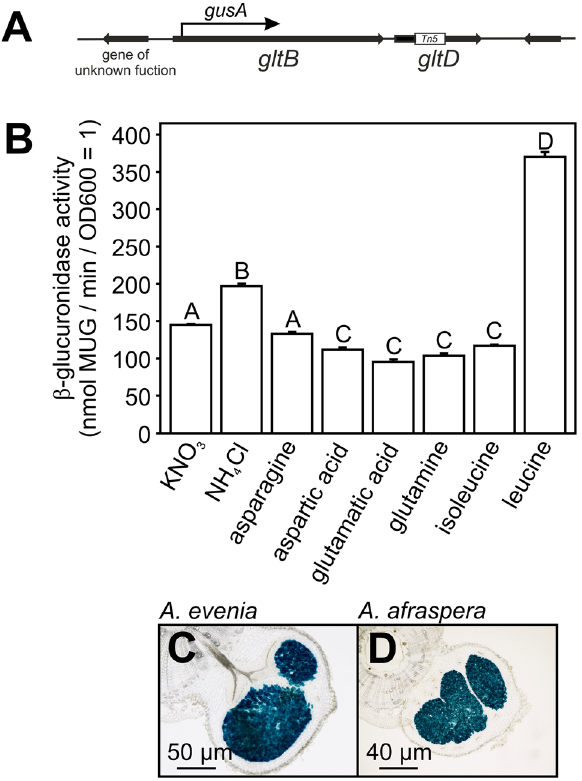
Figure 3. Activity of the Bradyrhizobium ORS285 GOGAT promoter under free-living and symbiotic conditions. ( A ) Schematic representation of the genomic region containing the gltB - gltD operon in Bradyrhizobium ORS285. The insertion of the Tn5 transposon in the gltD gene is indicated by a white block and the point of the transcriptional fusion with the gusA gene in the P GOGAT reporter strain with and arrow. ( B ) β-glucuronidase activity of Bradyrhizobium ORS285 P GOGAT -gusA cells grown for 48 h in minimal BNM-B medium using the indicated nitrogen source. The results are from one representative experiment with three technical replicates for each experimental condition. Error bars represent standard errors of the mean and letters represent conditions with significant difference according to the Tukey’s test (P < 0.05). GOGAT promoter activity in nodules of ( C ) NF-independent A. evenia and ( D ) NF-dependent A. afraspera plants. A. evenia and A. afraspera plants were infected with the Bradyrhizobium ORS285 P GOGAT - gusA reporter strain and at 15 dpi,